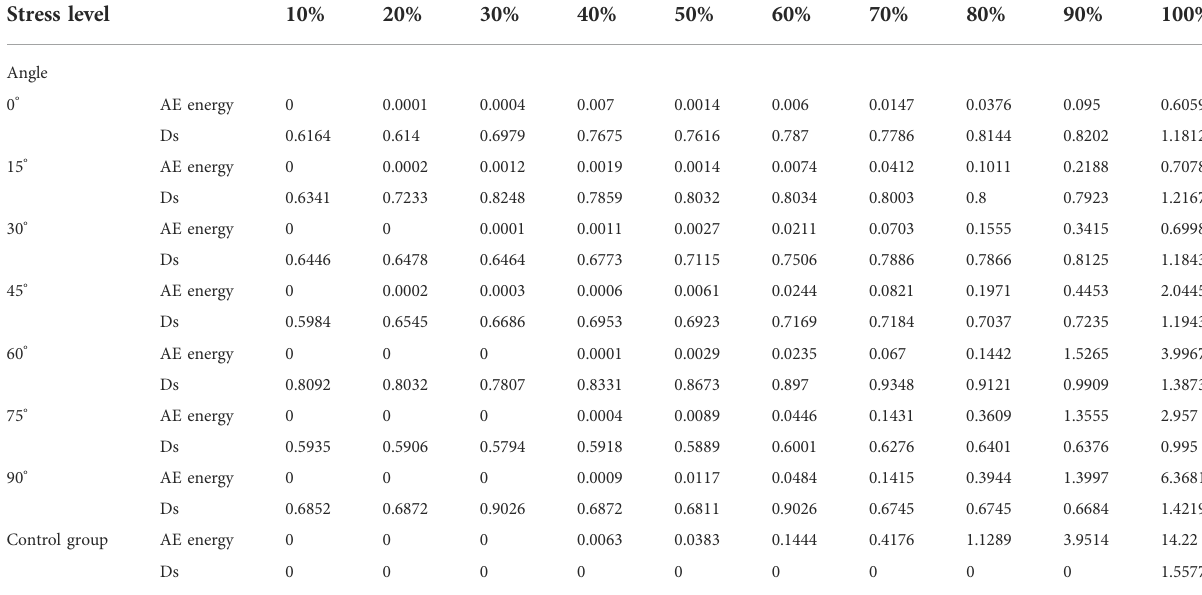
TABLE 2 AE energy and fractal dimension Ds at different stress levels for different natural crack inclination angles. Stress level